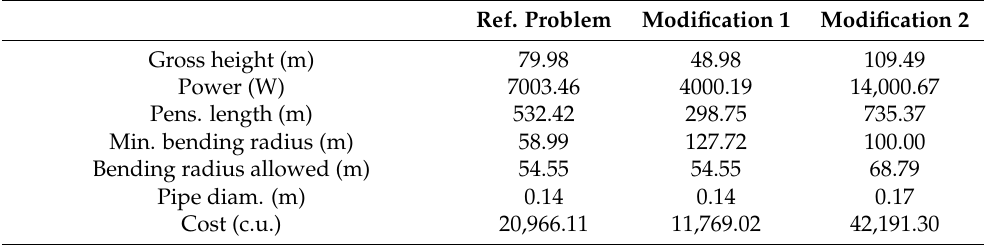
Figure 14. Layout of the optimal solutions obtained for the modified problems 1 ( left ) and 2 ( right ). Table 4. Summary of the optimal solutions obtained for the reference case and the two